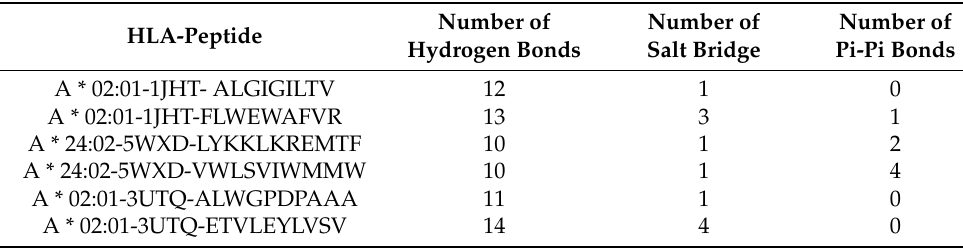
Table 4. Number of different types of